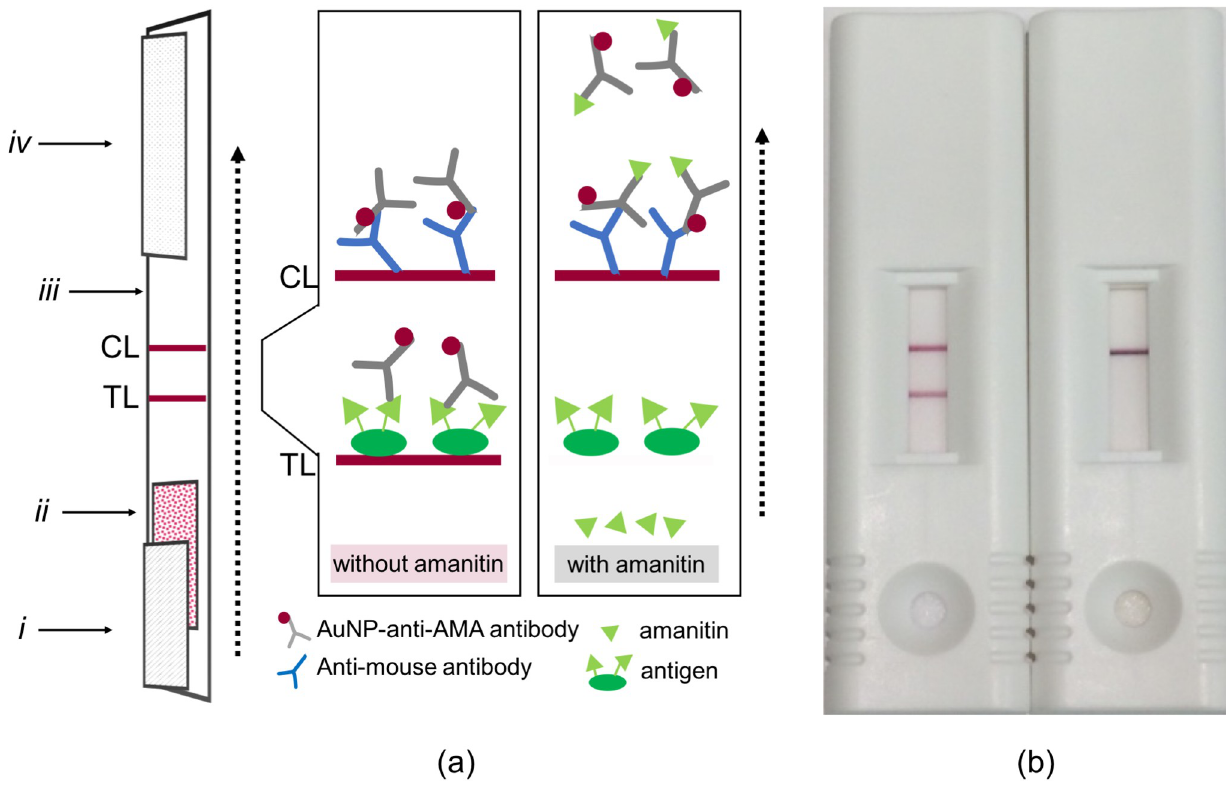
Fig 2. Depictions of the test strips used in this study. (a) Schematic diagram of the lateral flow strip along with a diagram of the reagents on the control line (CL) and test line (TL). (b) A view of the strips when used in a cassette. The left cassette is an example of a sample without amatoxins (negative) and the right cassette is an example of a sample with amatoxins (positive). ( i ) sample pad, ( ii ) conjugate pad, ( iii ) nitrocellulose membrane, ( iv ) wicking pad, and the arrow indicates the flow direction.